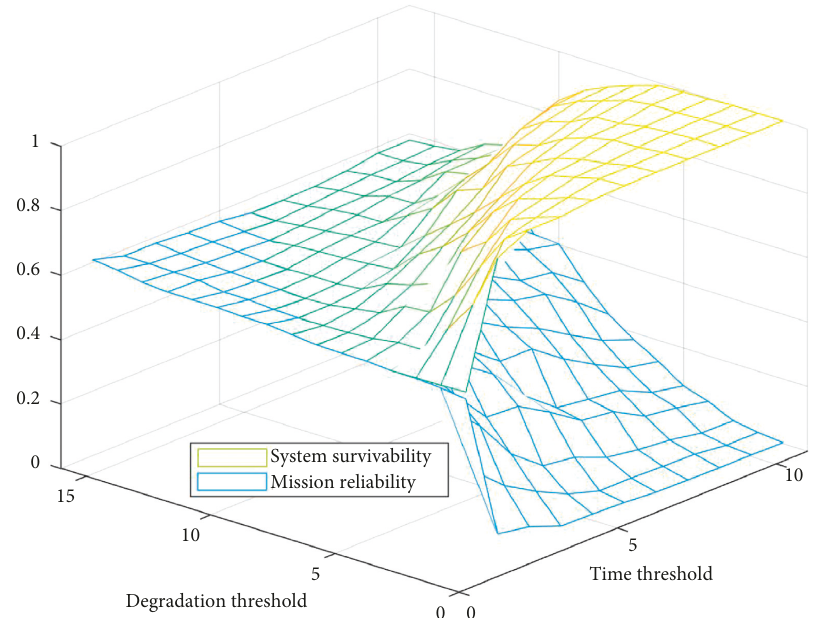
Figure 1: Mission reliability and system survivability under single